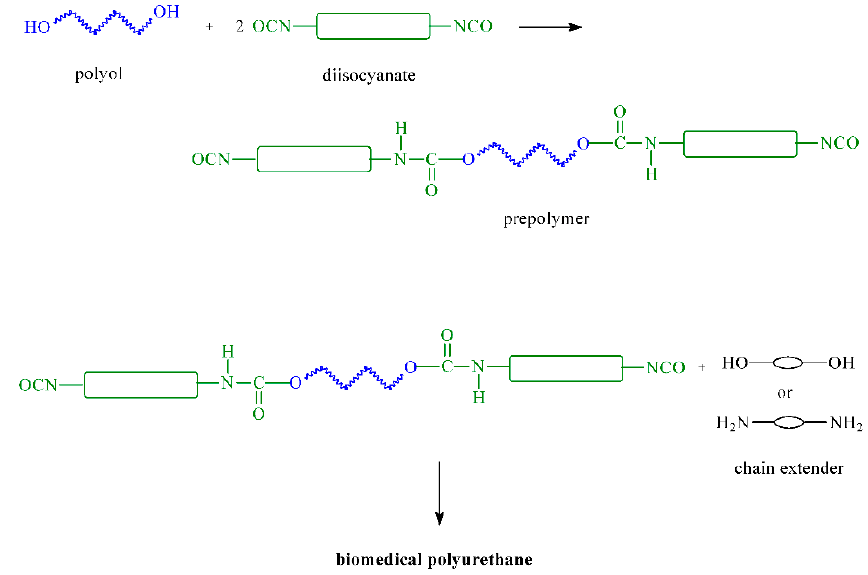
Figure 1. Synthesis of biomedical polyurethanes with the prepolymer method.